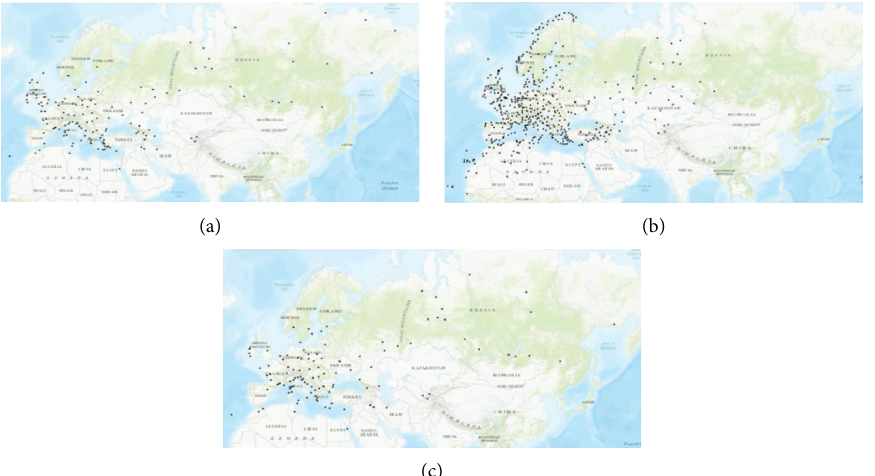
Figure 8: LCC of the Europe-Russia component after its isolation from the network. Te black dots are the remaining airports after attacks on the world air transportation network (a) strength attack, (b) weighted betweenness attack, and (c) weighted PageRank attack. Te LCC isolated by the strength and weighted PageRank attacks covers almost all countries sparsely. Te LCC is well distributed in all the initial component areas for the weighted betweenness